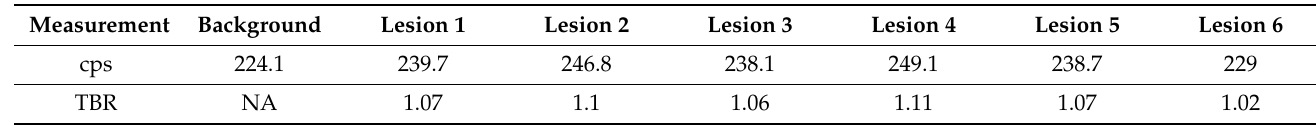
Figure 3. PET calibration phantom model demonstrating FDG decay over time (half-life 110 min). Table 1. Tumor to background ratio of simulated tumors in dilute FDG phantom model. FDG-containing spheres were loaded into a fluid-filled model containing fluid with dilute FDG to a 4:1 SUV at 110 min. This demonstrated that TBR decreased when lesions were within a metabolically active background. Median TBR 1.07.